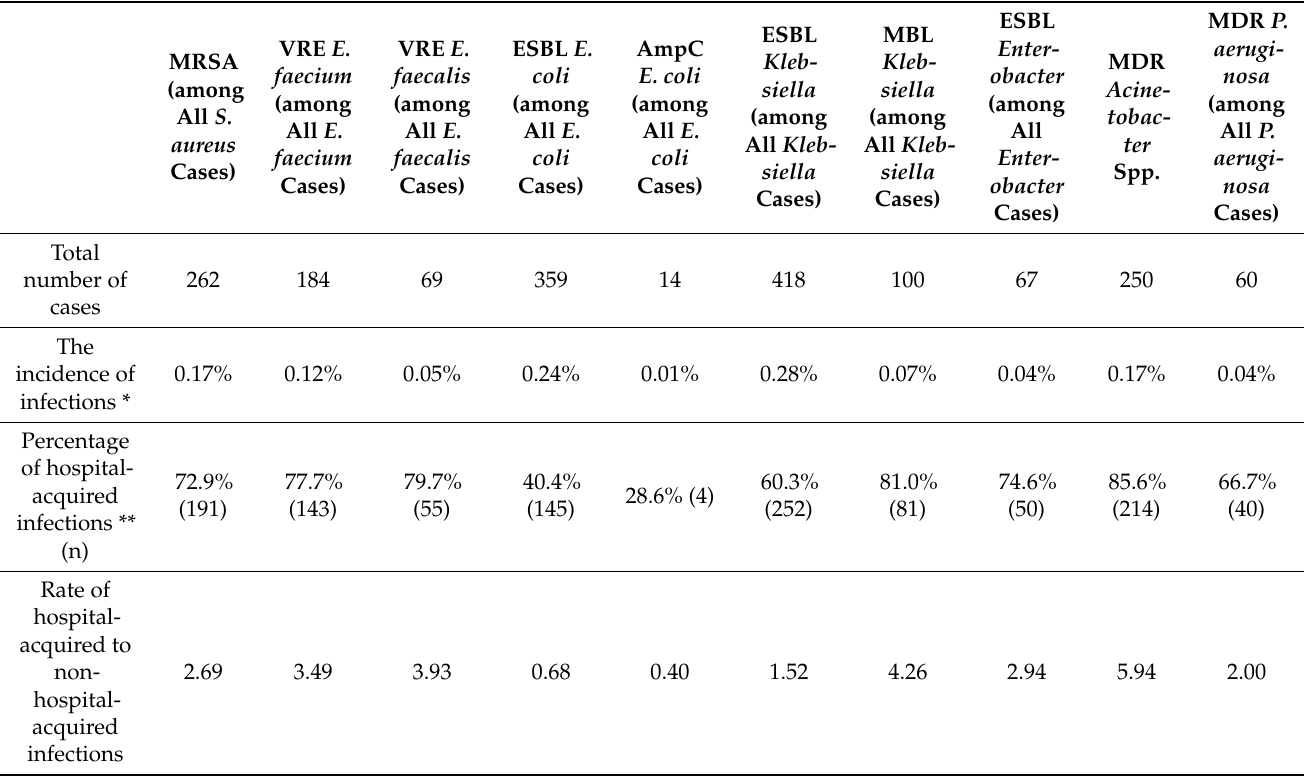
Table 3. Multi-drug resistant bacteria as the etiological factor of infections.